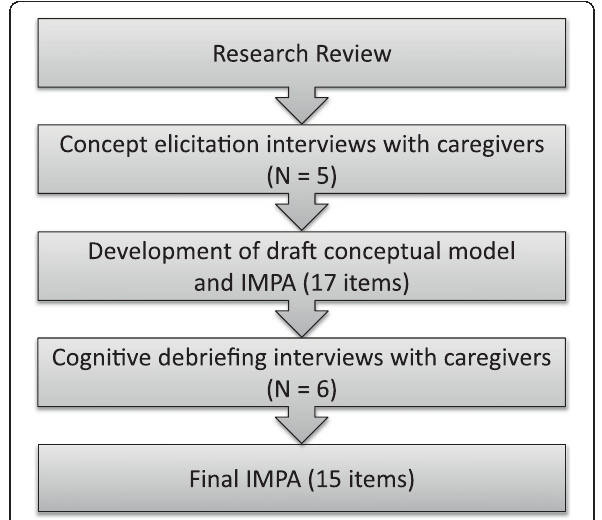
Fig. 1 Instrument Development Process. IMPA = Impact of